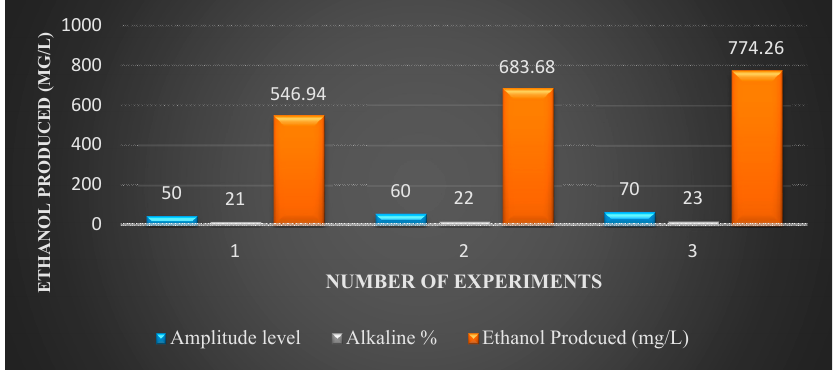
Figure 6. Ethanol production (mg/L) using NaOH and ultrasound pretreatment combined.